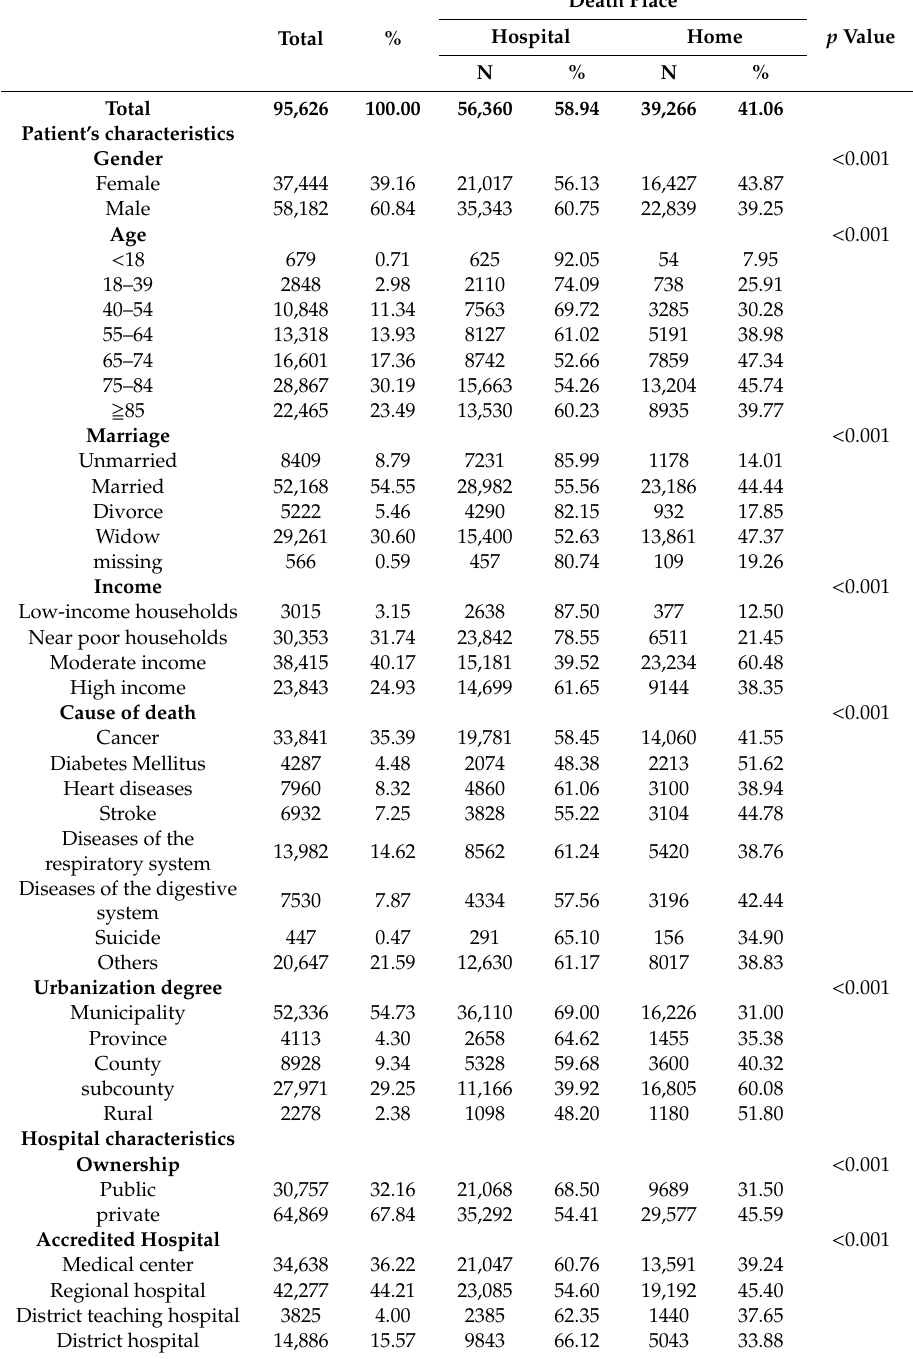
Table 1. Situation of discharge for inpatients facing impending death in 2011: univariate